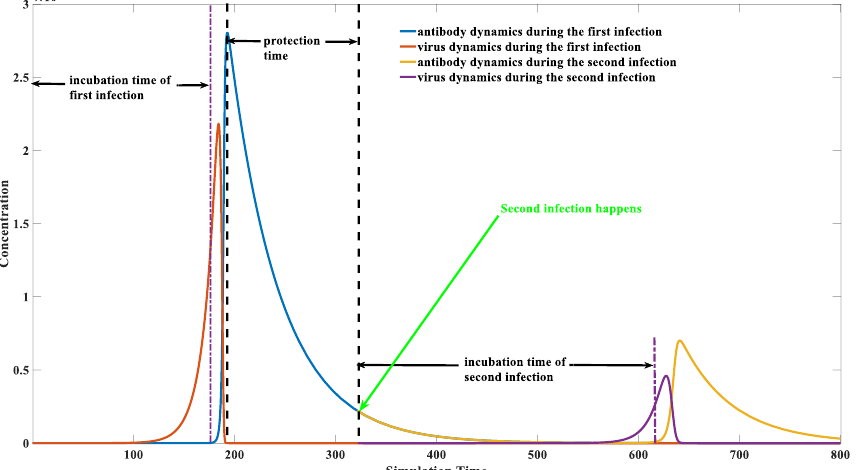
Figure 8. An illustration of protection time calculation. The parameter set we used is: x (0) = 0, y (0) = 100, z (0) = 10, p (0) = 10,000, k 1 = 0.1, k 2 = 1 × 10 − 7 , k − 2 = 1 × 10 − 14 , k 3 = 1, k 4 = 2, k 5 = 0.02, k 6 = 0.02, k 7 = 1 × 10 − 8 , k − 7 = 1 × 10 − 14 . Incubation time is calculated as the time interval between virus entrance and the production of antibodies. The viruses would engage a proliferation earlier than the antibodies. The patient is still asymptomatic even though the virus has reached a high level. Symptoms such as fever would appear when the antibody–virus complexes reach beyond a specific threshold. The second infection is marked with a green arrow. It can be seen in this figure that a second infection could occur when the IgG level drops below a certain level. It does not necessarily require a zero IgG level when a breakthrough infection